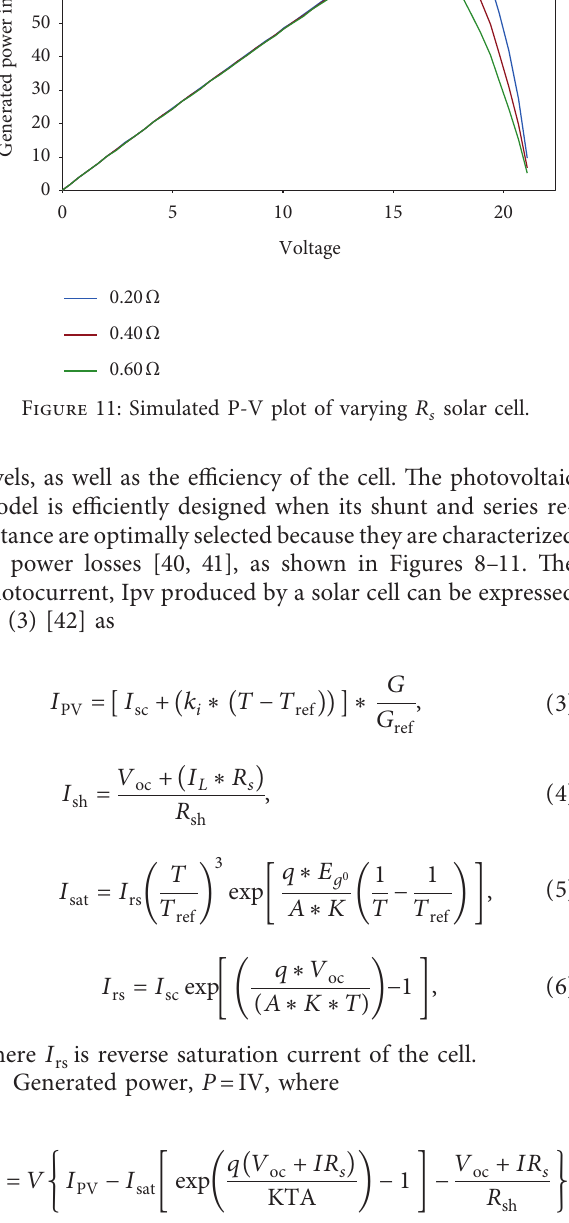
s of solar cell.